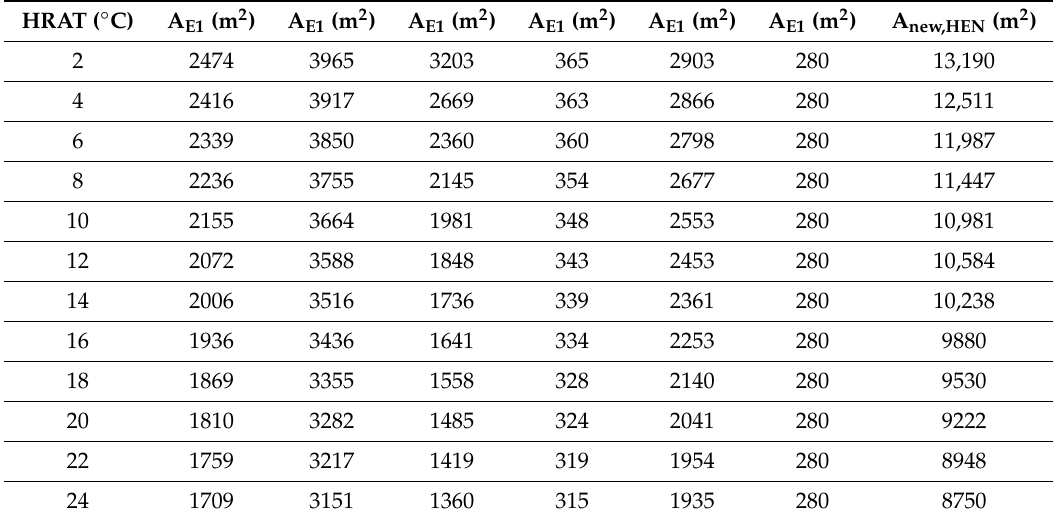
Table A12. Heat transfer area for HEN exchangers after heat-shifting, using option 2.